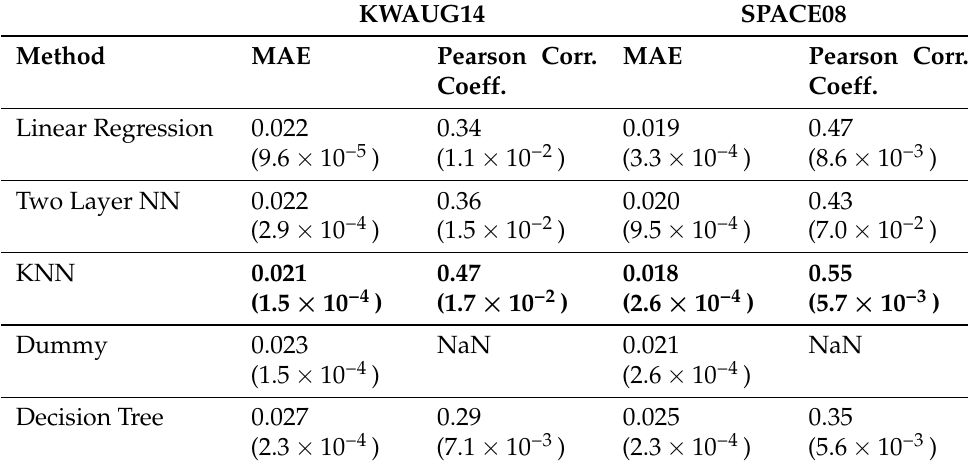
Table 2. Conventional regression results using CIR-derived features.